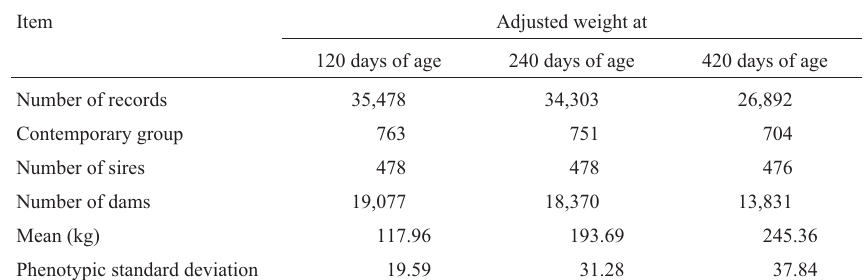
Table 1 - Number of records, contemporary groups, sires, means and phenotypic standard deviations for the adjusted weights at 120, 240 and 420 days of age.